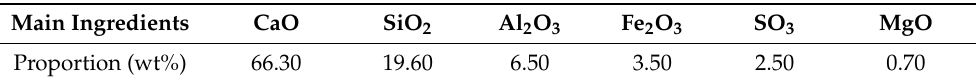
Table 4. The main component of P · O 42.5 grade ordinary Portland